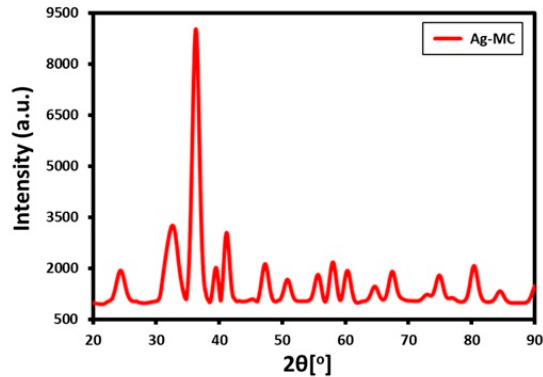
Figure 3. XRD diffractogram of green synthesized silver nanoparticles using Myrtus communis L. extract (Ag-MC).